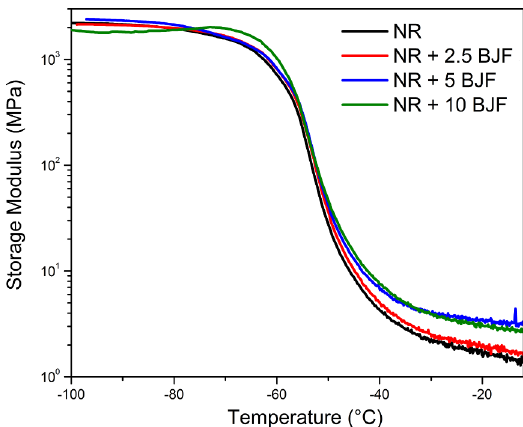
Figure 3. Storage Modulus versus temperature for NR composites.